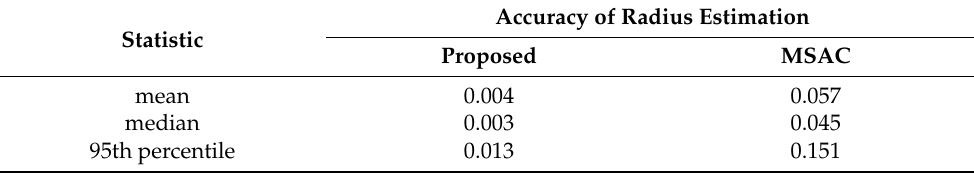
Figure 5. Cumulative probability distribution of the accuracy of the estimated center of the 50,000 sim- ulated point cloud configurations using the MSAC and proposed methods. Table 3. Mean, median, and 95th percentile of the accuracy of the estimated center using the proposed and MSAC